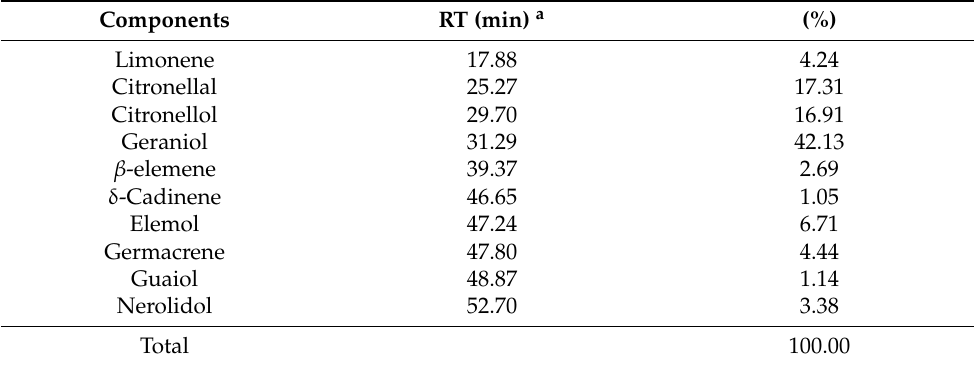
Table 2. Survival of fibroblasts exposed to the essential oil of C. winterianus . Natural Product